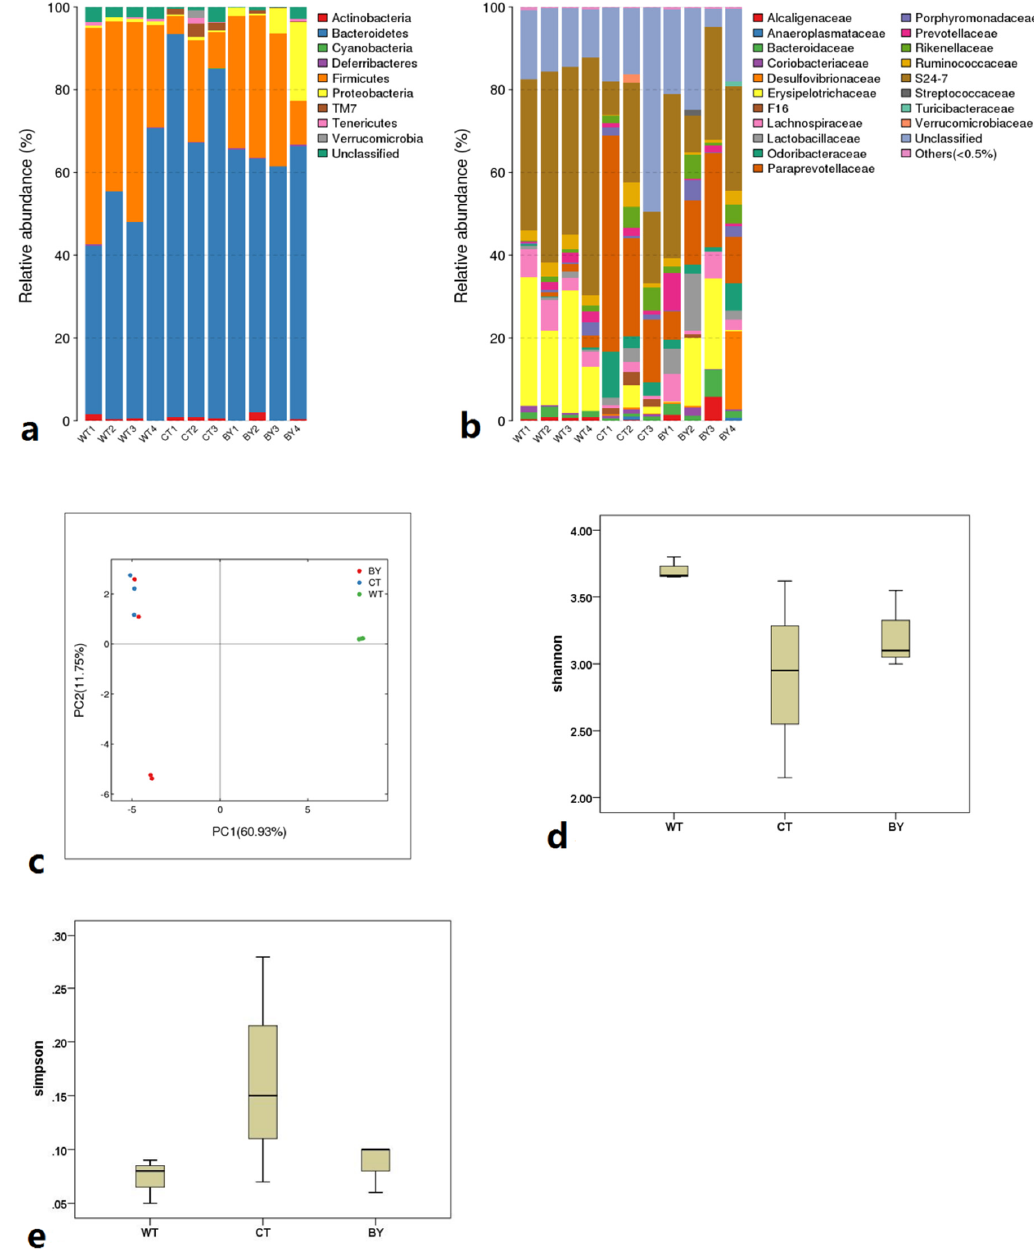
The microbiota composition of proximal colon contents in three groups of mice. The microbiota composition at the phylum level ( a ) and the family level ( b ) in three groups, the principal component analysis in three groups ( c ), the shannon index ( d ) and the simpson index ( e ) of biodiversity in three groups, Wild-type mice (WT), IL-10 − / − mice without treatment (CT), IL-10 − / − mice treated with butyrate (BY); Data are presented as mean ± SEM (* p < 0.05 and ** p < 0.01 versus CT group).